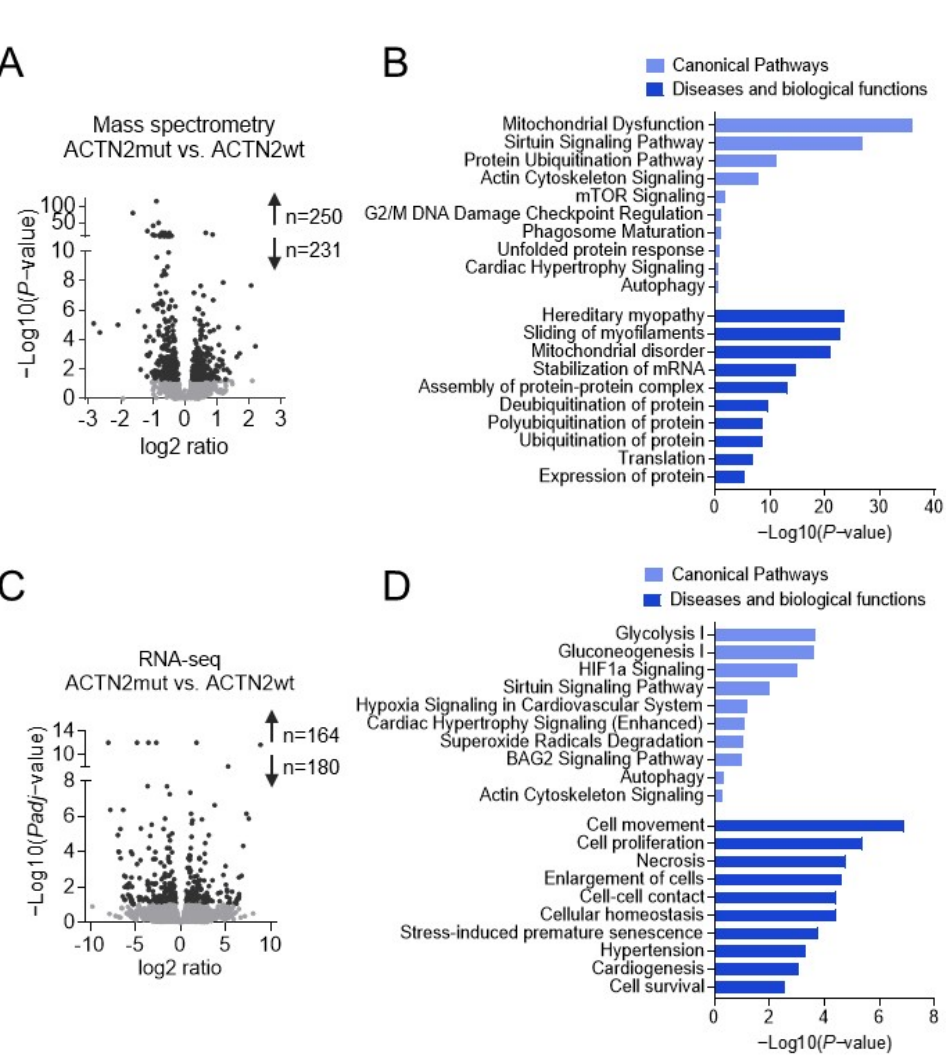
Figure 3. MS and RNA-seq analysis of 30-day-old, 2D-cultured hiPSC-CMs. ( A ) Alterations in protein levels between ACTN2mut vs. ACTN2wt (250 up, 231 down) hiPSC-CMs based on MS are displayed in a volcano plot that shows the -Log10 of p -value vs. magnitude of change (log2 ratio) whereby light grey dots indicate p > 0.05 and dark grey dots p < 0.05. ( B ) Selected hits of significantly dysregulated canonical pathways and biological functions in 2D-cultured ACTN2mut vs. ACTN2wt hiPSC-CMs based on MS analysis using Ingenuity Pathway Analysis (IPA). Unsupervised IPA was performed for significantly altered proteins (Fisher’s exact test; p < 0.05). ( C ) Alterations in mRNA levels in ACTN2mut vs. ACTN2wt (164 up, 180 down) hiPSC-CMs based on RNA-seq analysis are displayed in a volcano plot that shows the -Log10 of Padj -value vs. magnitude of change (log2 ratio) whereby light grey dots indicate FDR > 0.1 and dark grey dots FDR < 0.1. ( D ) Selected hits of significantly dysregulated canonical pathways and biological functions in 2D-cultured ACTN2mut vs. ACTN2wt hiPSC-CMs based on RNA-seq analysis using IPA. Unsupervised IPA was performed for significantly altered genes (Fisher’s exact test; FDR < 0.1).